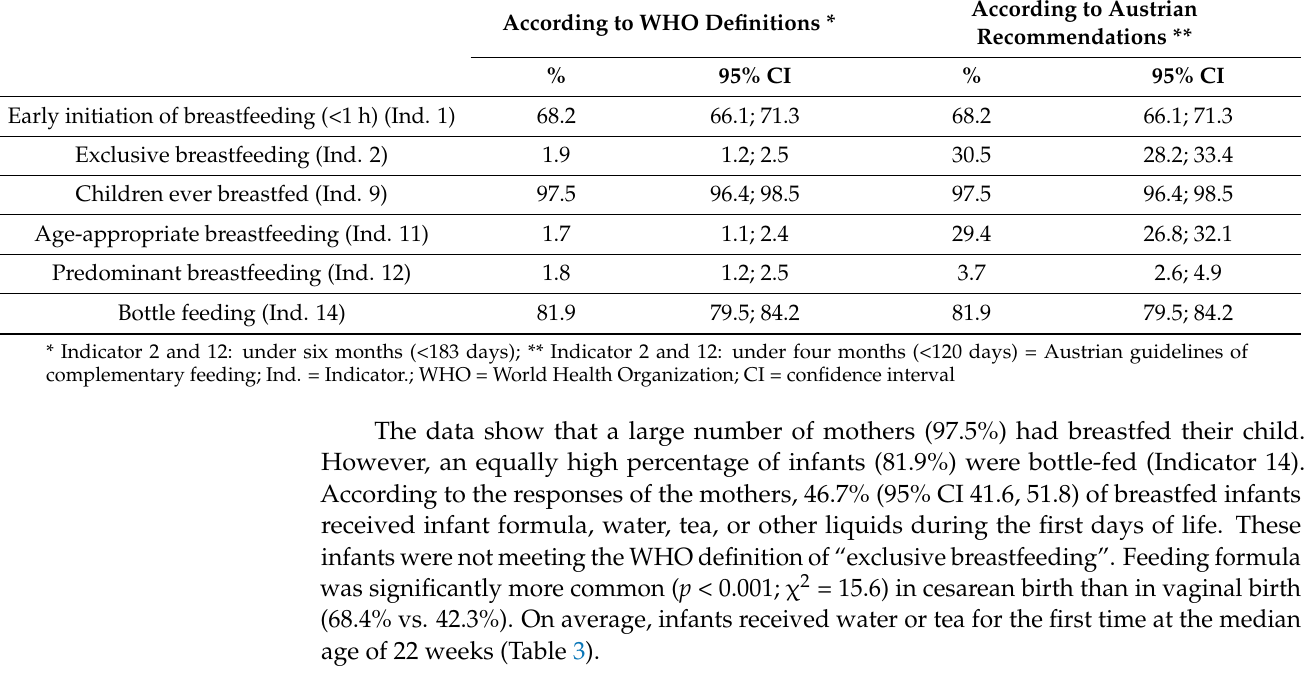
Table 2. IYCF indicators for breastfeeding according to WHO [22,23] and Austrian recommendations [26] in %. According to Austrian According to WHO Definitions *